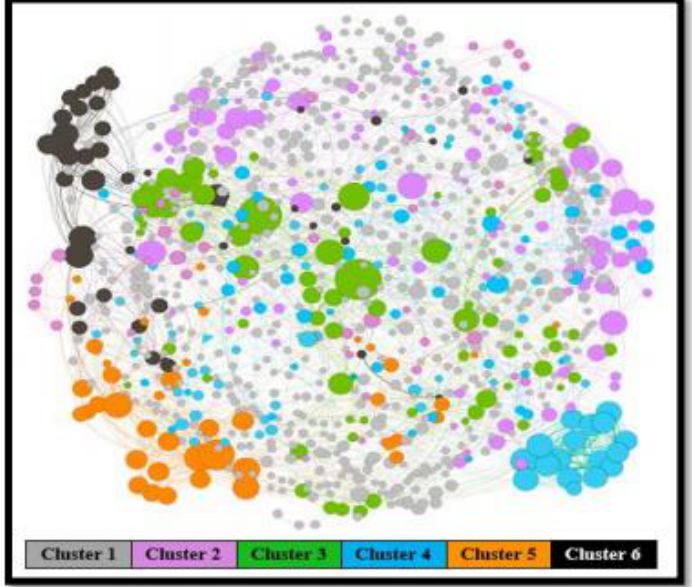
Figure 2. Force atlas structure of six